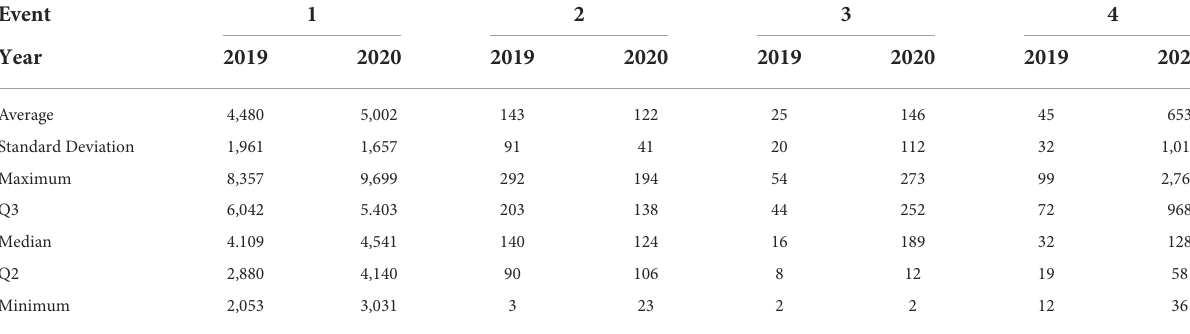
TABLE 2 Monthly frequency statistics, by event and year.